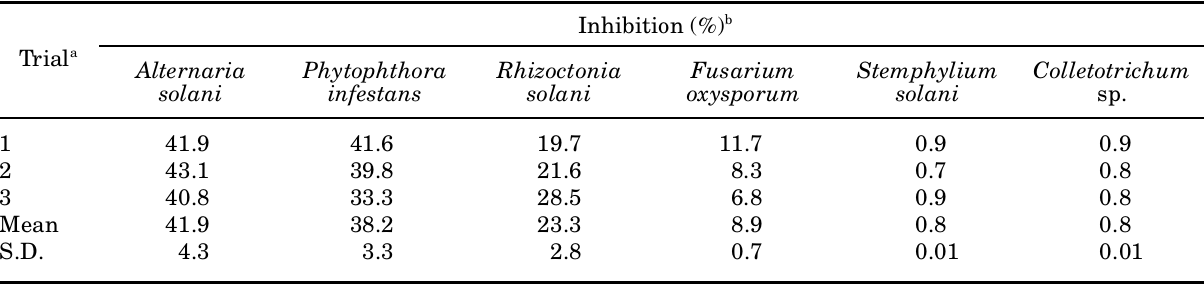
Table 1. In vitro inhibition of fungal growth by wild honey